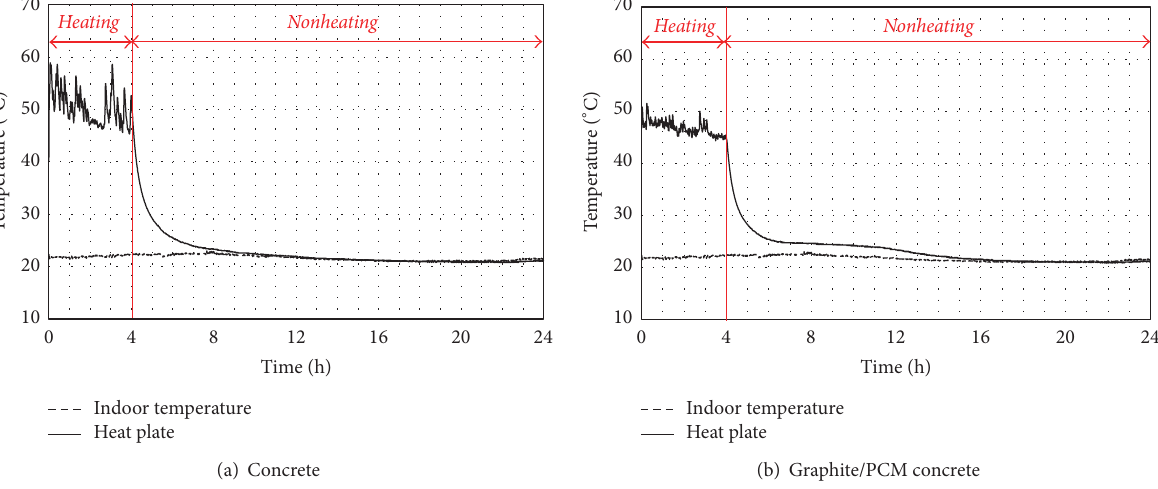
Figure 5: Heat plate and indoor temperature boundary conditions of the